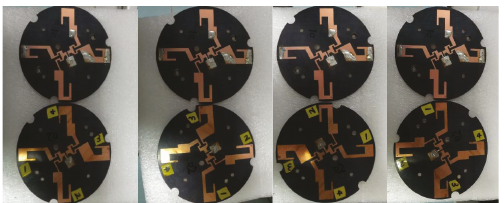
Figure 12: The experimental model of the dual-element antenna